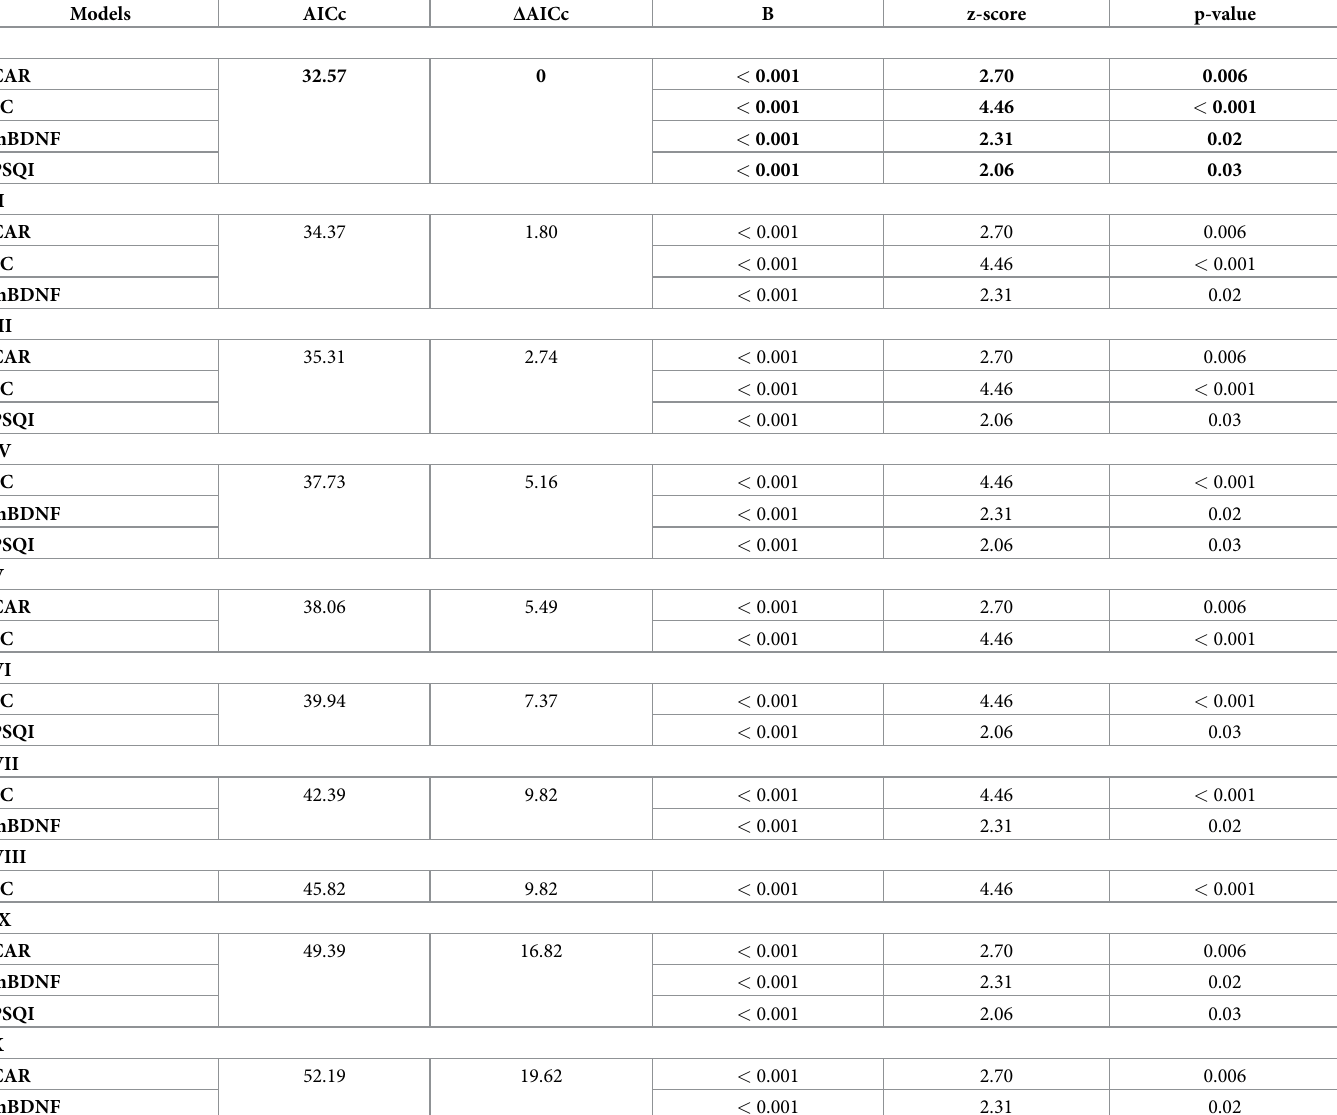
Table 2. Regression models for major depression disorder chronicity, possible predictive models of discrimination between patients in first depressive episode (MD: n = 30) and patients with treatment-resistant depression (TRD: n = 28). Models